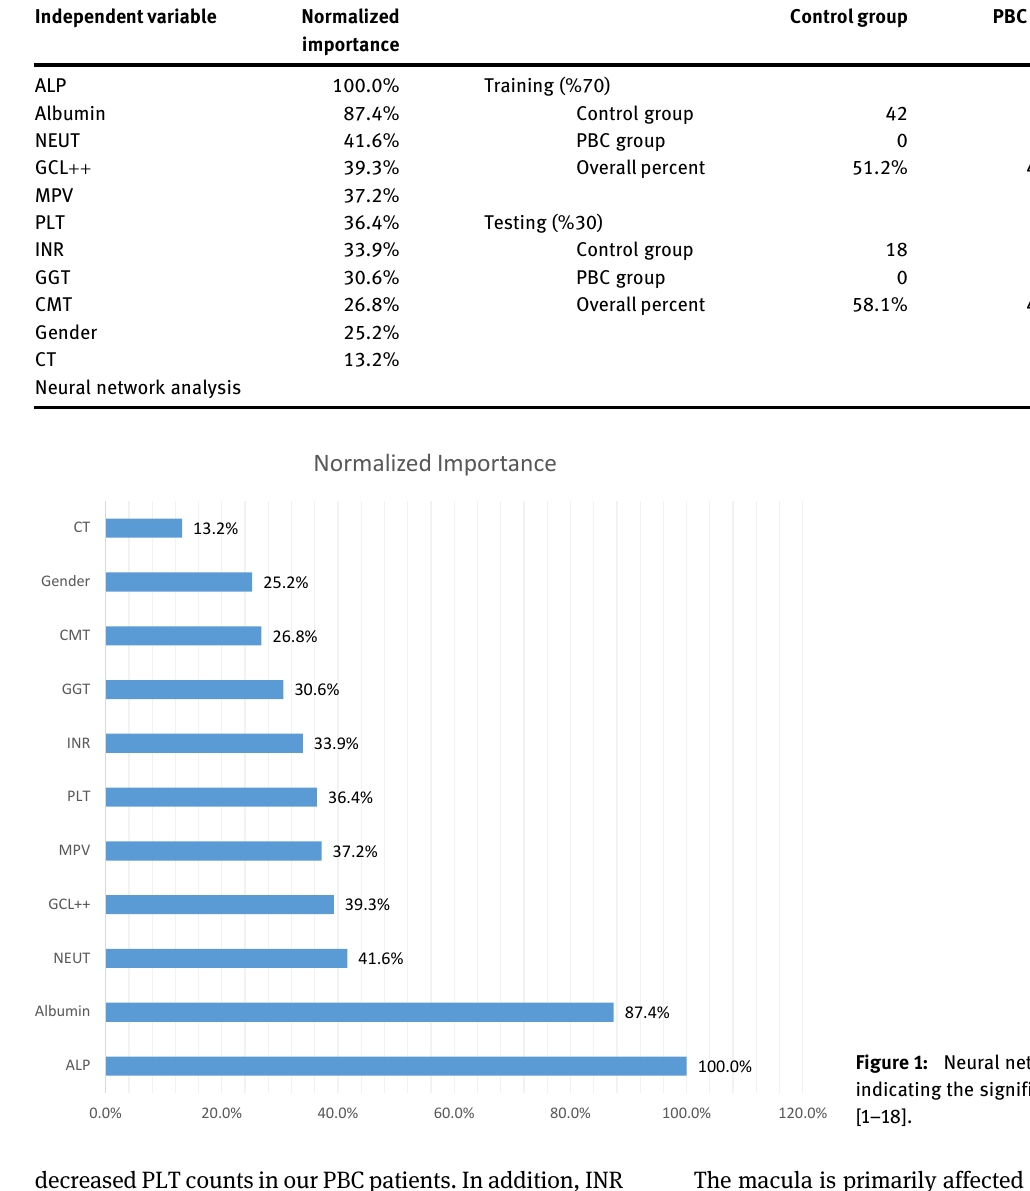
Table  : The variables with the highest signi fi cance associated with the groups. Variable importance